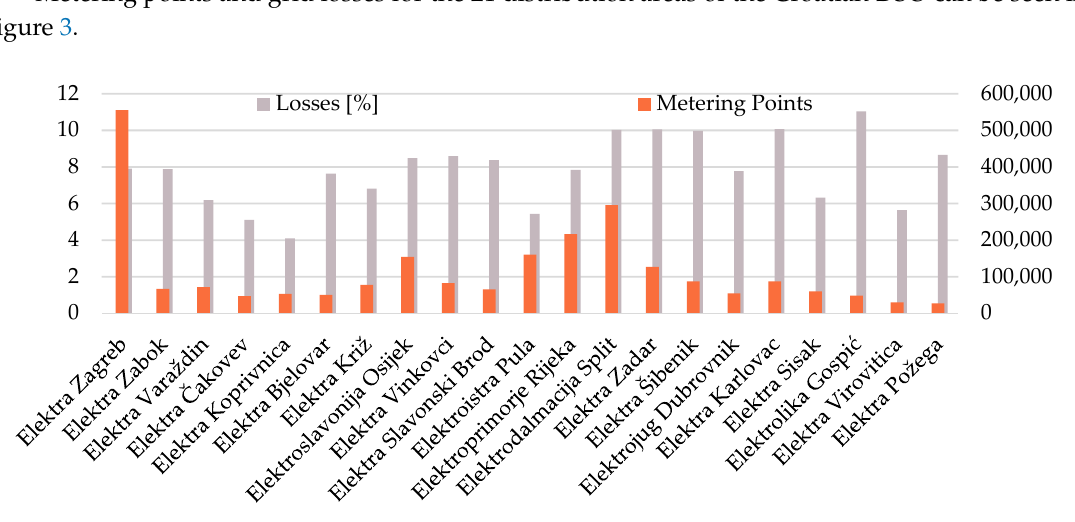
Table 1. Neighboring Grid Characteristics [34].